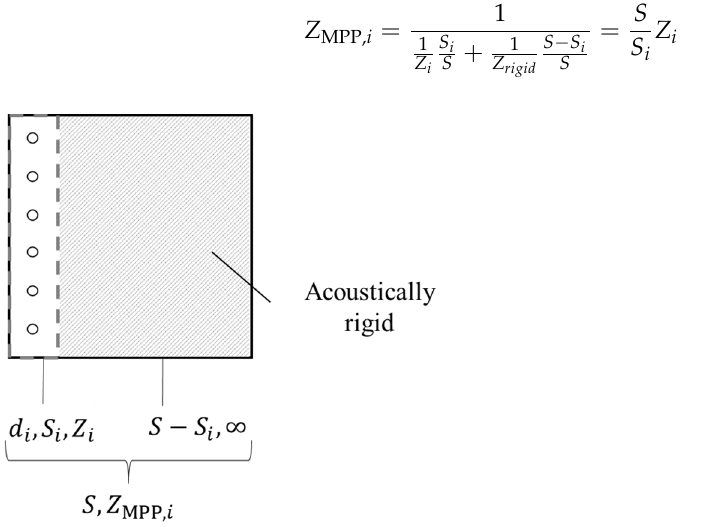
Figure 8. A diagram of the calculation procedure for the impedance of a hypothetical MPP. The area surrounded by the dashed line is the part with holes, and the hatched area is the part without holes, which is acoustically rigid.